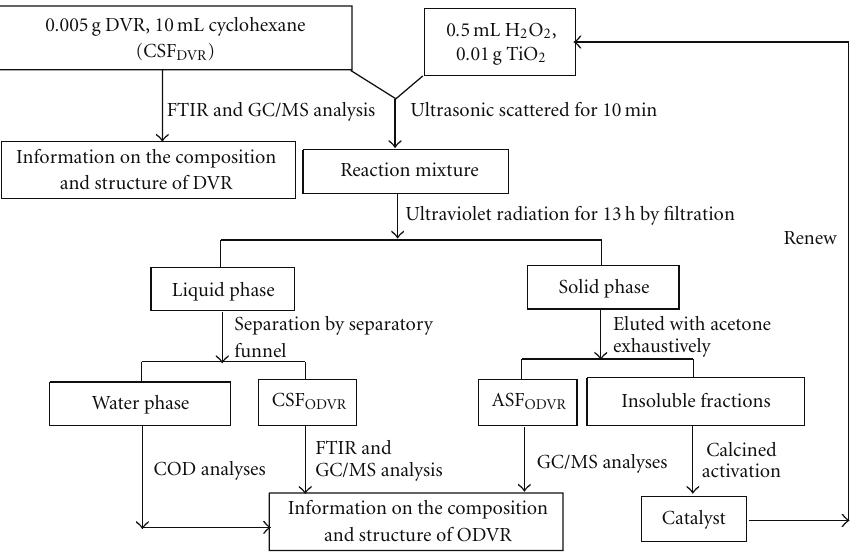
Figure 1: Procedure for DVR oxidation, subsequent treatment, and products